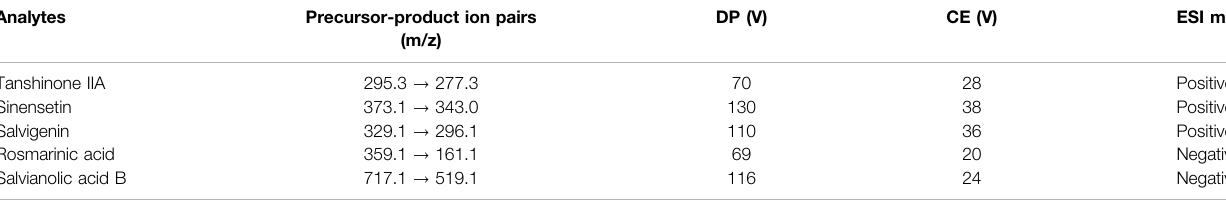
TABLE 2 | MS/MS parameters for analyte determination in MRM mode. Analytes